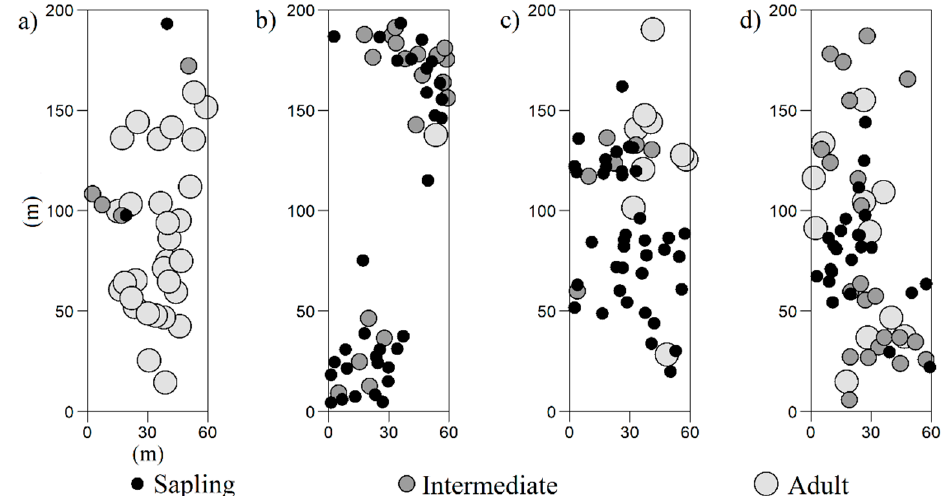
Figure 2. Spatial distribution of Pinus cembra L. within the plots from the Retezat National Park ( a , b ); and from the Natura 2000 site ( c , d ). The quantitative marks indicate the tree sizes: sapling (10–130 cm height), intermediate (1–15 cm diameter breast height), adult ( > 15 cm diameter breast height).